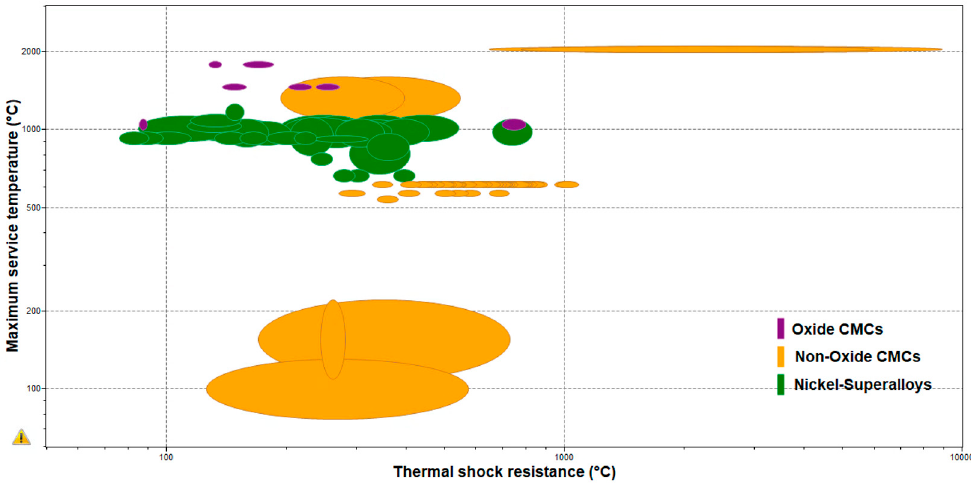
Figure 13. Comparison of maximum service temperature vs. thermal shock resistance of available CMCs.